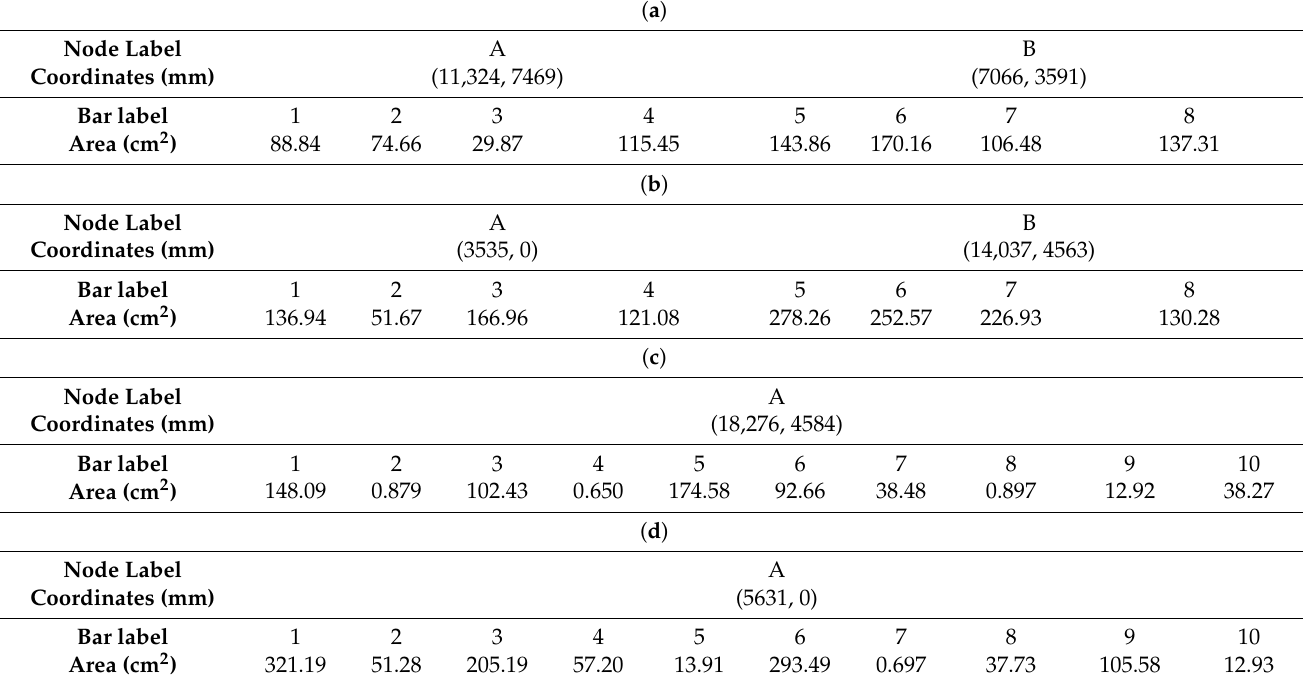
Table 7. Detailed data of the truss layout in experiment 2. ( a ) Load case I with constraint